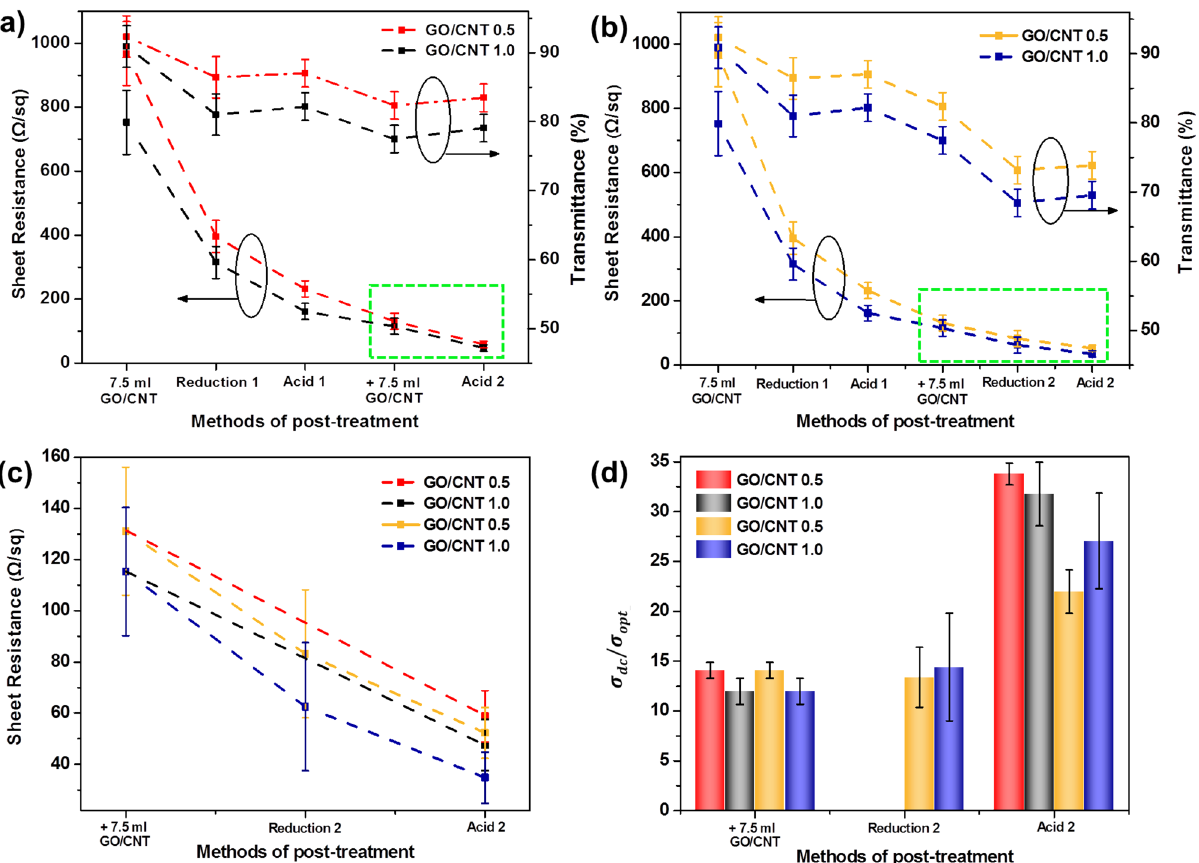
Figure 6. Sheet resistance and transmittance of bilayer films after treatments: ( a ) S-RGO/CNT0.5 and S-RGO/ CNT1.0, ( b ) D-RGO/CNT0.5 and D-RGO/CNT1.0. Comparison of ( c ) sheet resistance values and ( d ) σ dc values shown in green boxes of ( a , b,